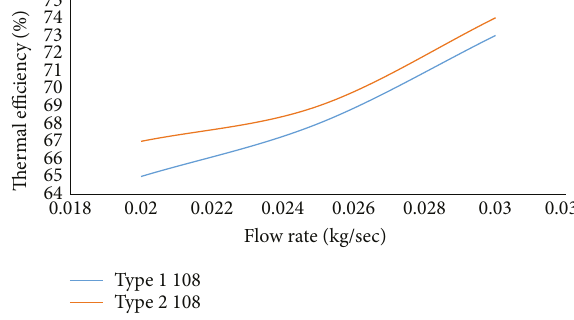
Figure 9: Variation of thermal e ffi ciency versus fl ow rate (kg/s) for 108 pc arrangements.